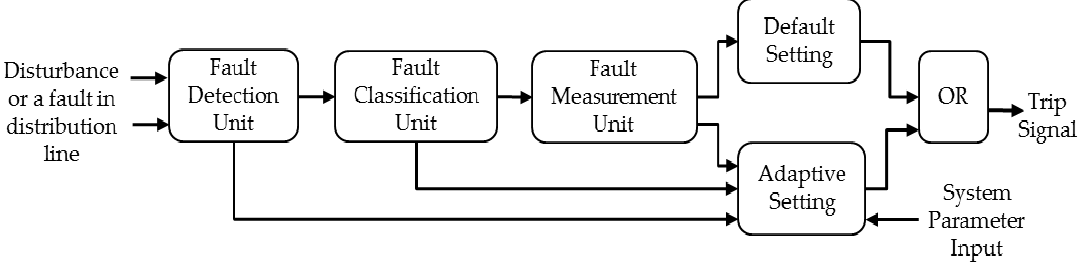
Figure 6. Block diagram of an adaptive distance relay.